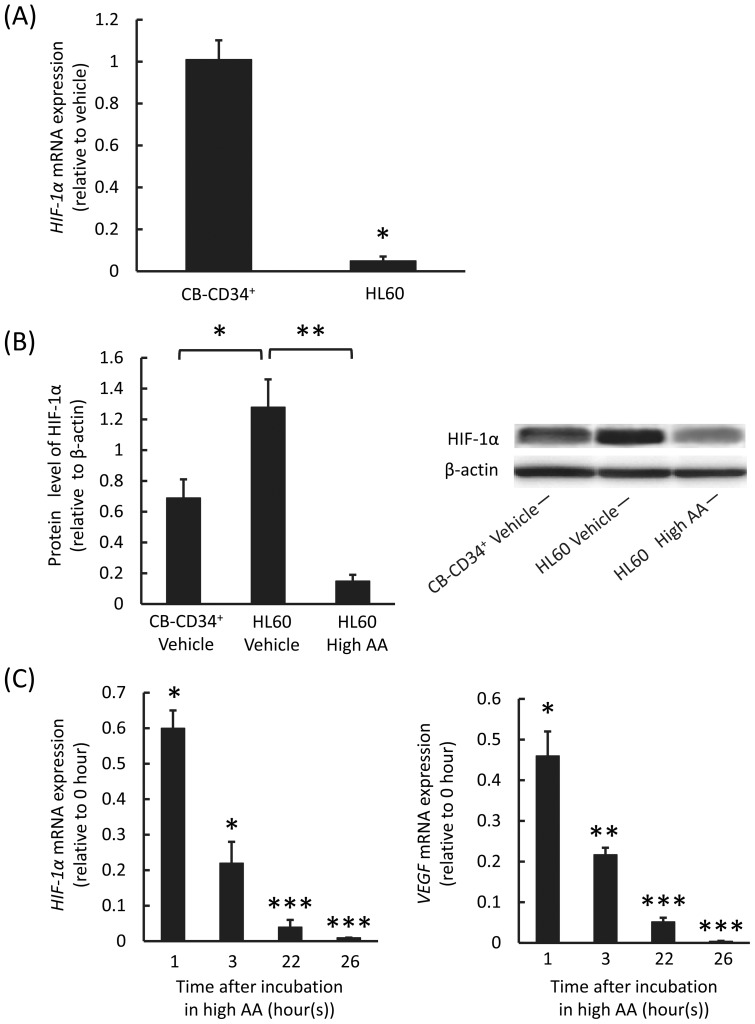
Expression of angiogenesis-related molecules in human leukemic and CB-CD34+ cells exposed to the vehicle or to high AA.A) Quantitative real-time PCR (qRT-PCR) analysis of HIF-1α mRNA in CB-CD34+ and HL60 cells. The cells were treated with vehicle or high AA for 1 h, and then washed, cultured, and analyzed after 24 h. There were no significant differences in the expression levels for the 2 conditions (P>0.05) in CB-CD34+ cells. In contrast, there were significant differences in the expression levels between the 2 conditions (*P<0.0001) in HL60 cells. The values represent the mean ± SD values of triplicate samples. B) Western blotting analysis of HIF-1α in CB-CD34+ and HL60 cells. The cells were treated with vehicle or high AA for 1 h, and then washed, cultured, and analyzed after 24 h. There were significant differences in the expression levels (*P<0.01, **P<0.0005). The values are mean ± SD values of triplicate samples. C) Sequential analysis of qRT-PCR results of HIF-1α and VEGF mRNA in HL60 cells. The cells were treated with high AA for 1 h, and then washed, cultured, and analyzed after 1, 3, 22, and 26 h. The expression of VEGF mRNA reduced along with that of HIF-1α over time. Compared with the expression levels at 0 h, there were significant differences in the expression levels (*P<0.01, **P<0.001, ***P<0.0001). The values represent the mean ± SD values of triplicate samples.